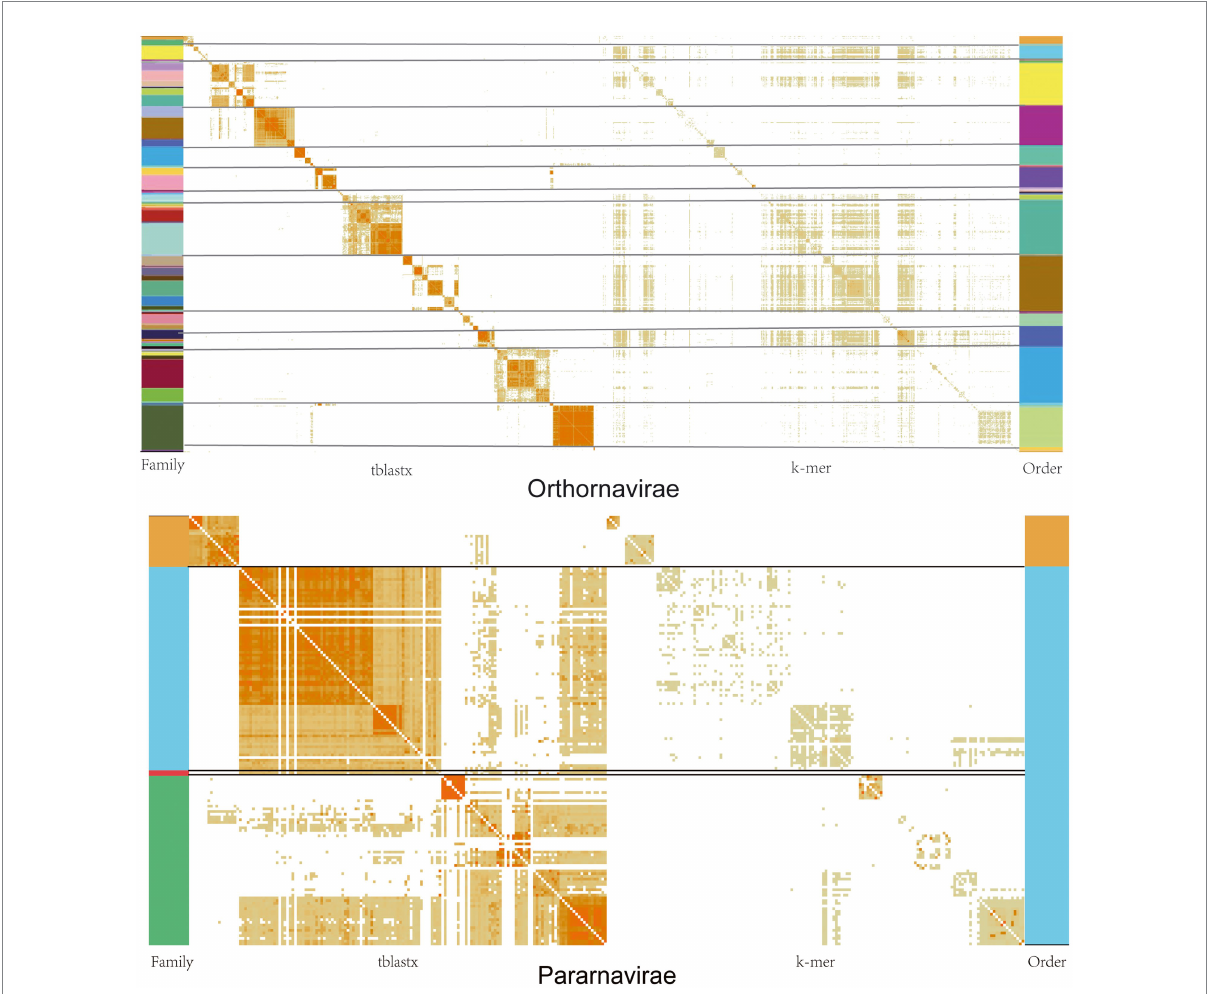
FIGURE. 4 Similarity matrices of viral genomes at the nucleic acid and protein levels in the Orthornavirae and Pararnavirae . The darker the orange in the figure, the greater the similarity. The different colors on the left represent the classification of different families, and the different colors on the right represent different